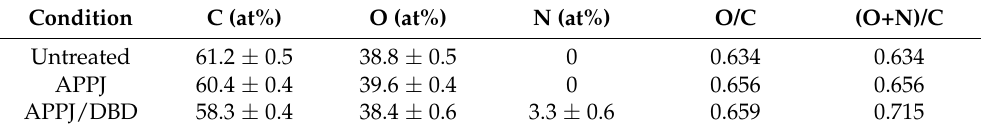
Table 3. Surface elemental composition of untreated, APPJ-treated and APPJ/DBD-treated PLA